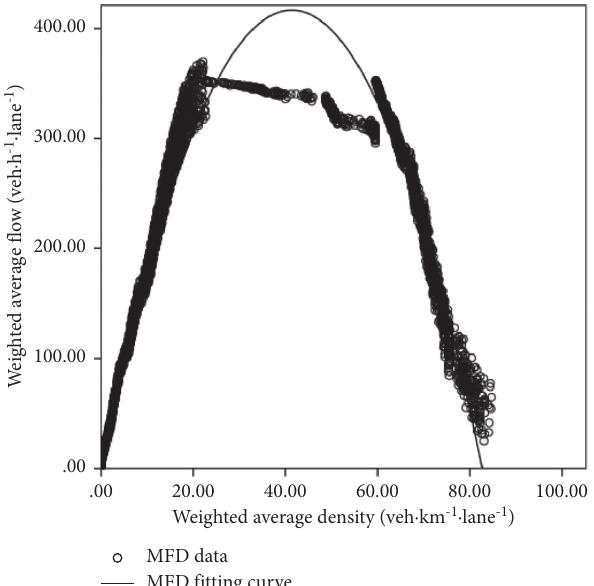
Figure 6: MFD scatter plot and fitting curve of the testbed network controlled by the proposed